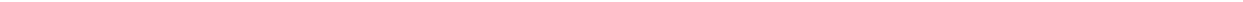
Fig. 2 Tau silencing reduces the survival of CDA-de fi cient cells. a MAPT mRNA levels determined by RT-qPCR in BS-Ctrl (BLM) and BS-BLM cells. b , c BLM and Tau levels determined by western blotting in BS-Ctrl (BLM) and BS-BLM cells using BLM and either Tau-5 ( b ) or Tau-1 ( c ) antibodies. d , e Tau protein quanti fi cation for Tau-5 ( d ) and Tau-1 ( e ) immunoreactivity. The β -actin signal was used as the control. The results are normalized against those for BS-BLM, which were set to 1. f – k Cells were fi rst transfected with either non-targeting or Tau siRNA. After 24 h, cells were again transfected with the indicated siRNAs. Two days after the second round of transfection, the cells were collected for western blotting f , i , or were plated, in a serial dilution series, in 12-well plates. Ten to 12 days later, colonies were fi xed and stained with crystal violet. Non-targeting siRNA was used as a control, with values set to 1 h , k . g , j Tau protein quanti fi cation after Tau-targeting siRNA depletion. l MAPT mRNA and m Tau protein levels determined in HeLa-Ctrl (Tau) and HeLa-shTau cells. n , o HeLa-Ctrl (Tau) and HeLa-shTau cells were fi rst transfected with the indicated siRNAs. After 24 h, cells were again transfected with the same siRNAs. Two days after the second round of transfection, cells were collected for western blotting ( n ), or were plated, in a serial dilution series, in 12-well plates. Seven days later, colonies were fi xed and stained with crystal violet. Non-targeting siRNA was used as a control, with the values obtained set to 1 ( o ). For qPCR, the mean value for 3 independent experiments is represented as a fold-change. B2M , β -actin , and TBP were used as housekeeping genes for qPCR normalization. For western blots, β -actin was used as a loading control. Each data bar is the mean of at least three independent experiments performed in triplicate. Error bars represent ± SEM. The signi fi cance of differences was assessed in two-tailed paired Student ’ s t -tests. *** P < 0.0005, ** P < 0.005, * P < 0.05, NS not signi fi